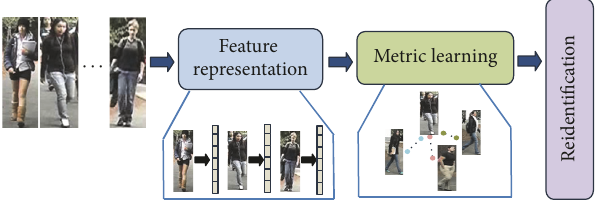
Figure 2: The general procedure of person reidentification.